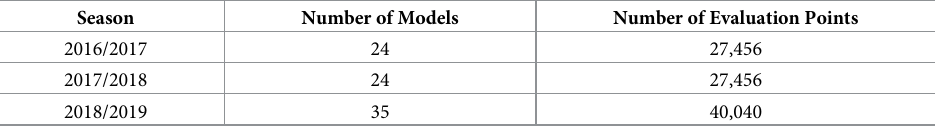
Table 1. Experimental setup for evaluating probabilistic coherence approaches. An evaluation point is defined as a unique region, season, epiweek, target, and model combination.